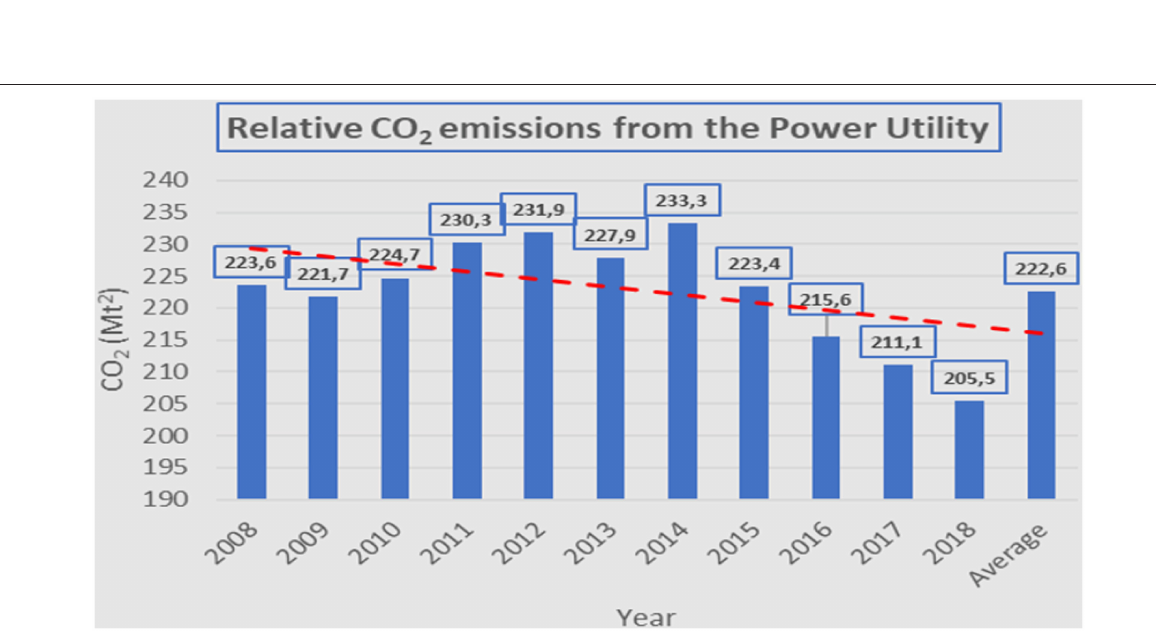
Frontiers in Sustainable Food Systems |